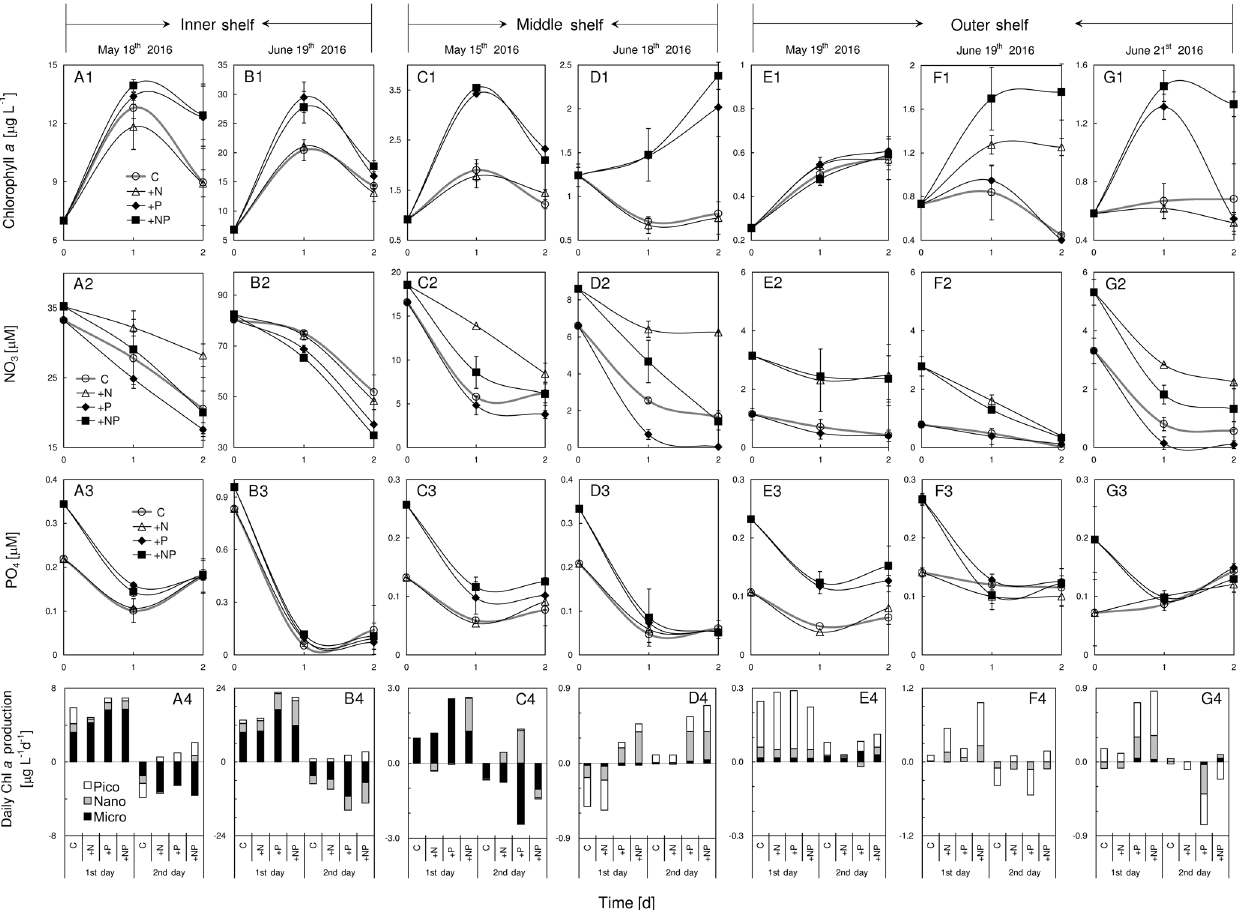
Figure 6. Responses of total chlorophyll a , nitrate, phosphate and size-fractionated daily chlorophyll a production rate of the surface water to various nutrient enrichments at (a1)–(a4) S1, (b1)–(b4) S2, (c1)–(c4) S3, (d1)–(d4) S4, (e1)–(e4) S5, (f1)–(f4) S6 and (g1)–(g4) S7 during May and June 2016. Station locations are in Fig. 1 with the initial conditions in Table 1; treatments include control (C), nitrogen alone ( + N), phosphorus alone ( + P) and nitrogen plus phosphorus ( + NP), respectively; chlorophyll a size fractionations of the initial waters for these stations are shown in Table